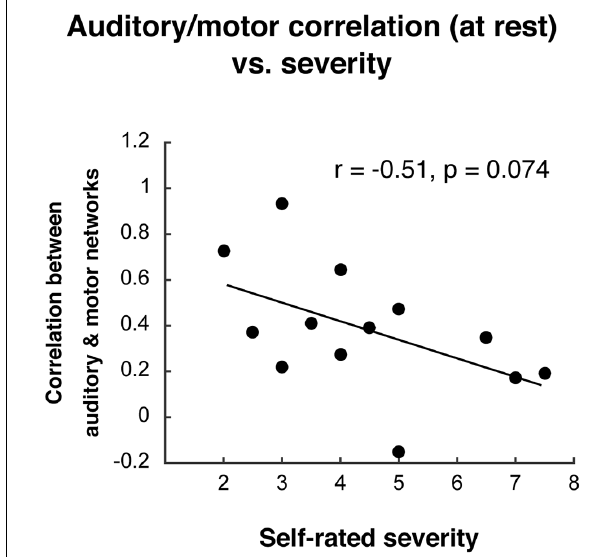
FIGURE 7 | Relationship between auditory-motor connectivity at rest (fisher-z transformed correlation) and self-rated stuttering severity.